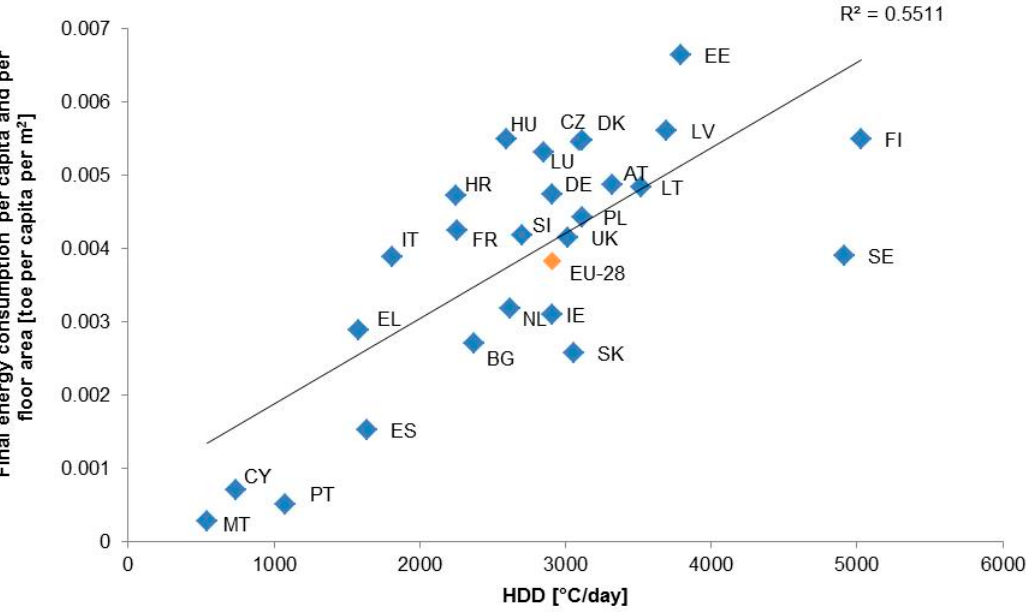
Figure 14. Correlation between Heating Degree Days (HDD) and residential energy consumption for space heating per capita and per floor area, in the EU-28 member states, 2015. Source: Eurostat, Odyssee.